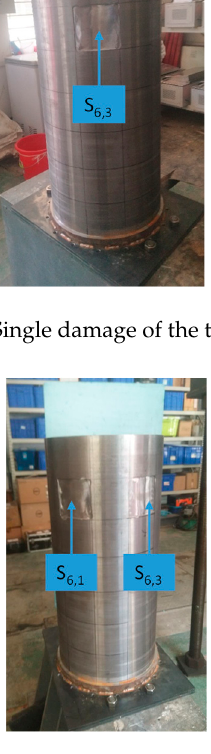
Figure 19. Multiple damages of the tank model.